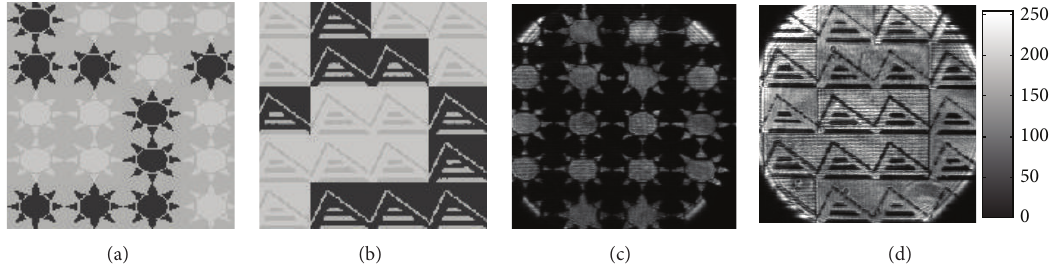
Figure 3: ((a) and (b)) Objects that were sent to the LCD using the HTM; ((c) and (d)) corresponding images of (a) and (b) obtained illuminating the SLM with the laser